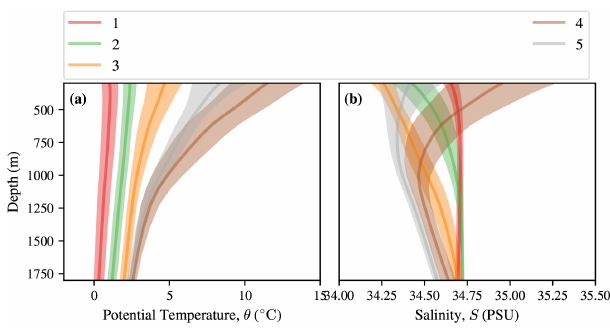
Figure 5. Profiles of the five GMM clusters between 300 and 1800m in (a) temperature and (b) salinity. This is calculated from the profiles classified using the statistical model fitted on the train- ing data itself. The central line is the mean, and the envelope on either side indicates 1 standard